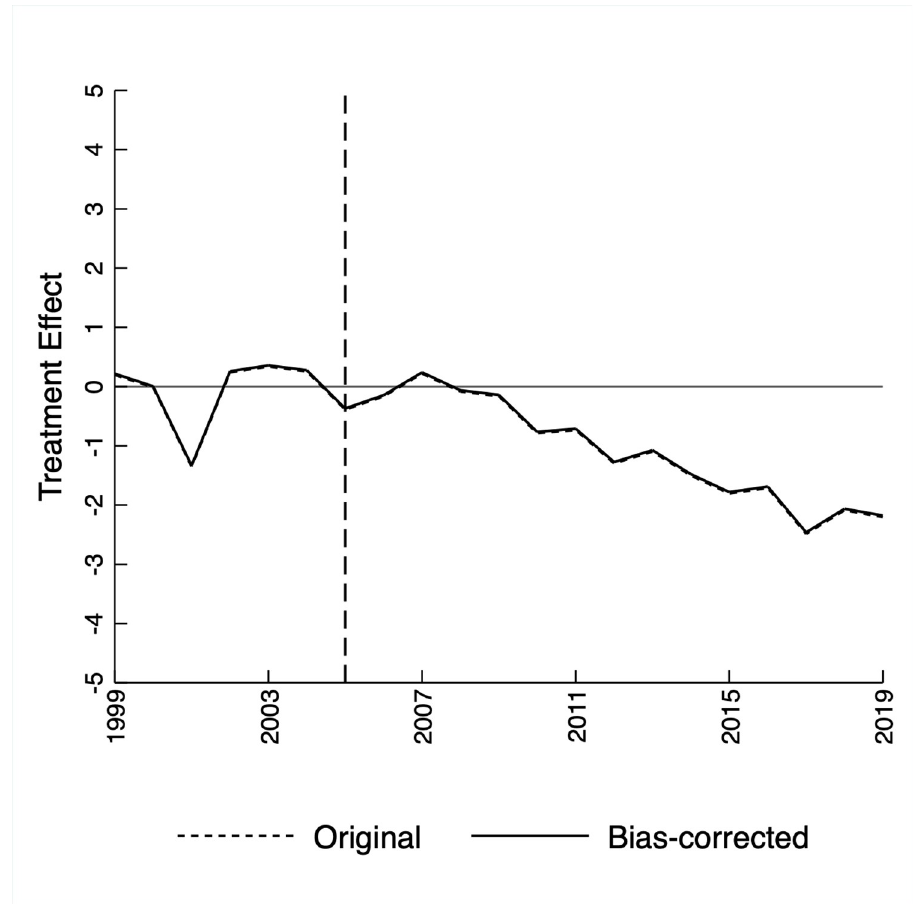
Fig 5. Original and bias-corrected treatment